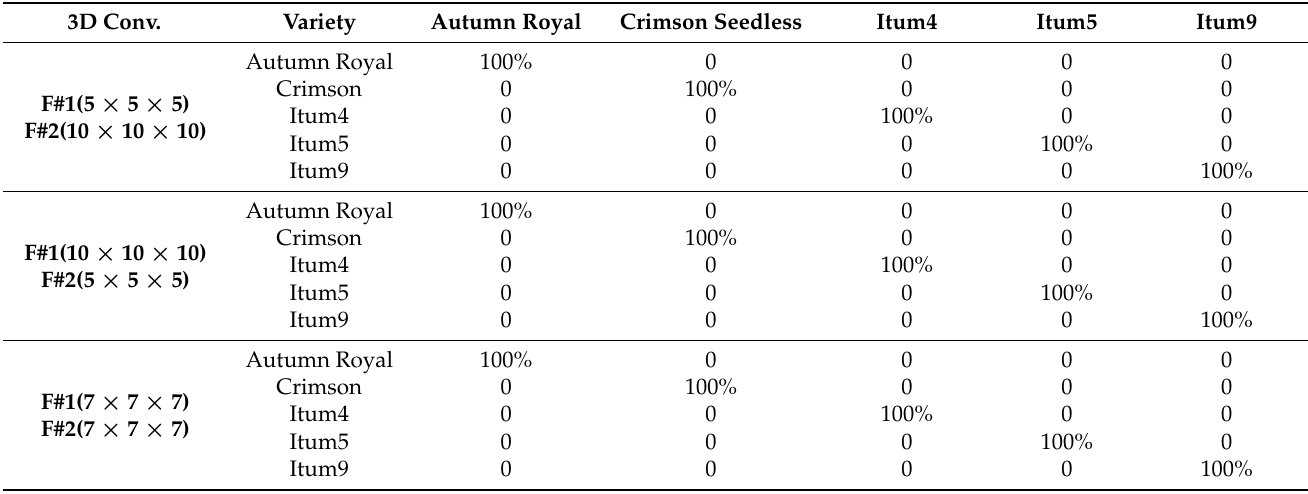
Table 7. Confusion matrix for the three configurations of the 3D convolution layer in the MBO architecture over test data. 3D